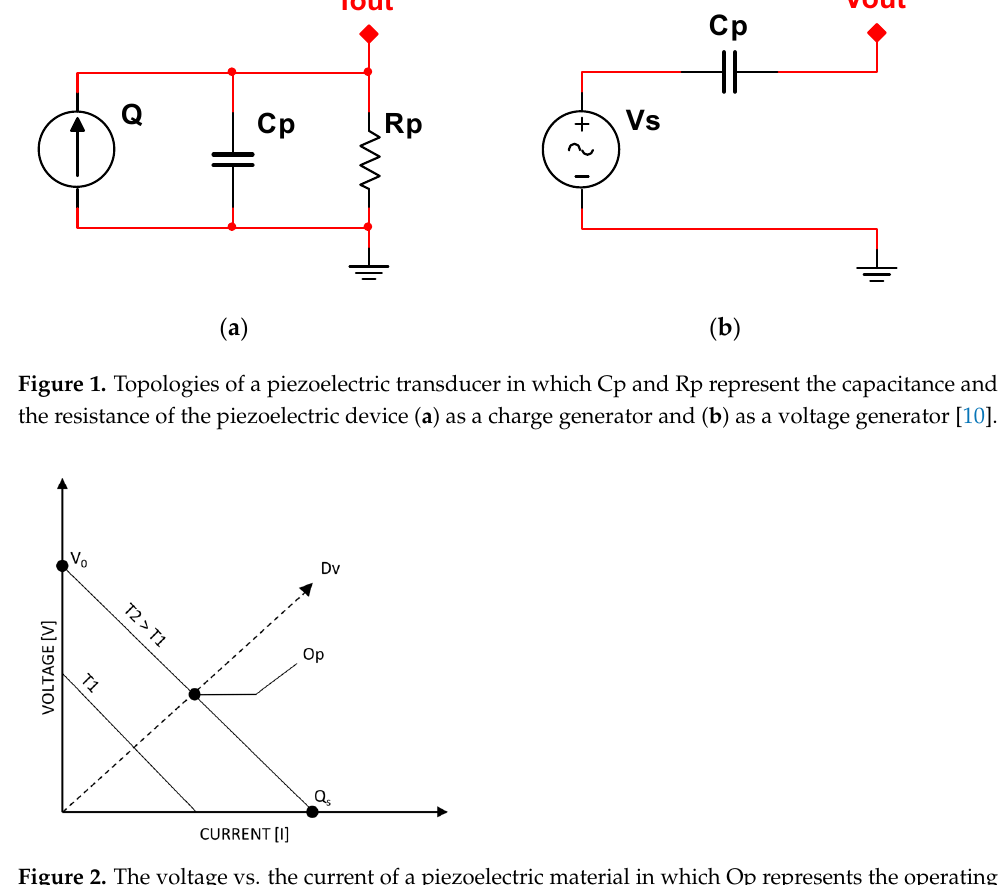
Figure 2. The voltage vs. the current of a piezoelectric material in which Op represents the operating point of maximum work and Dv refers to the direction of the increased voltage [11].